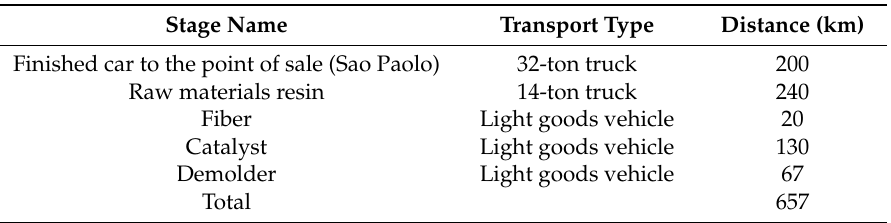
Table 11. Breakdown of raw materials and phases by transport